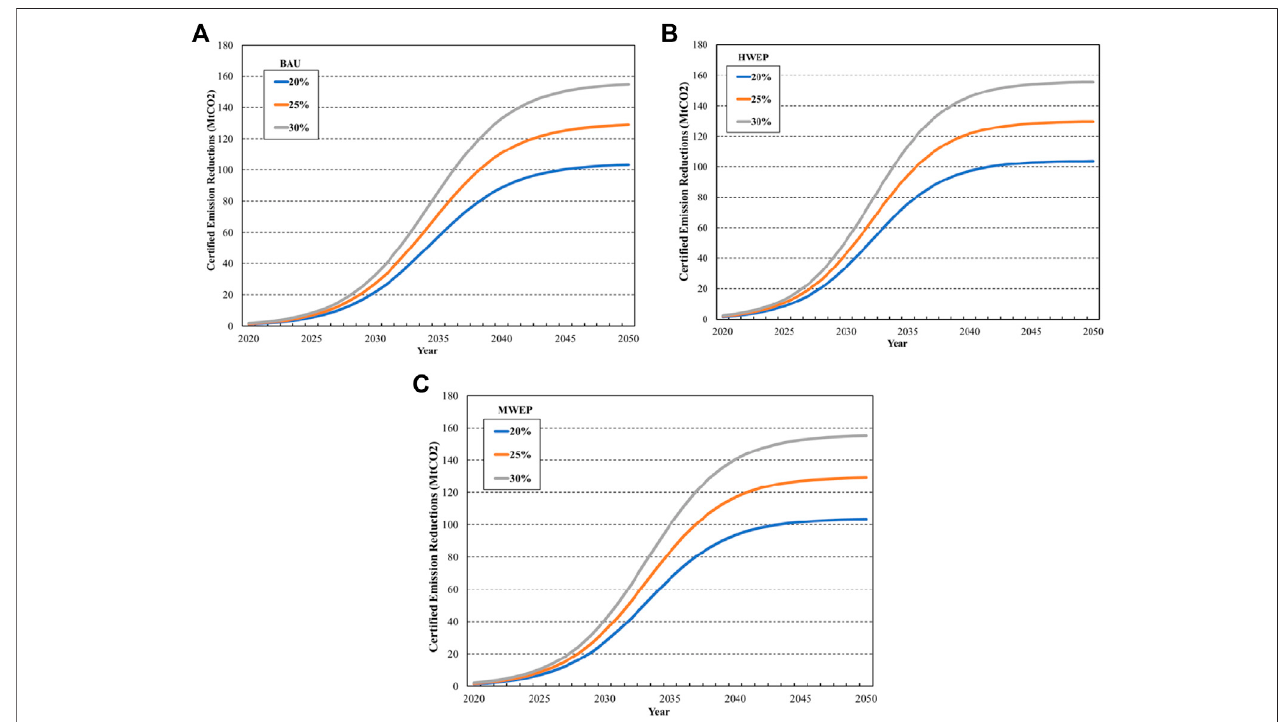
FIGURE 9 | Annual emission reduction from wind power under (A) BAU scenario, (B) HWEP scenario, and (C) MWEP scenario.